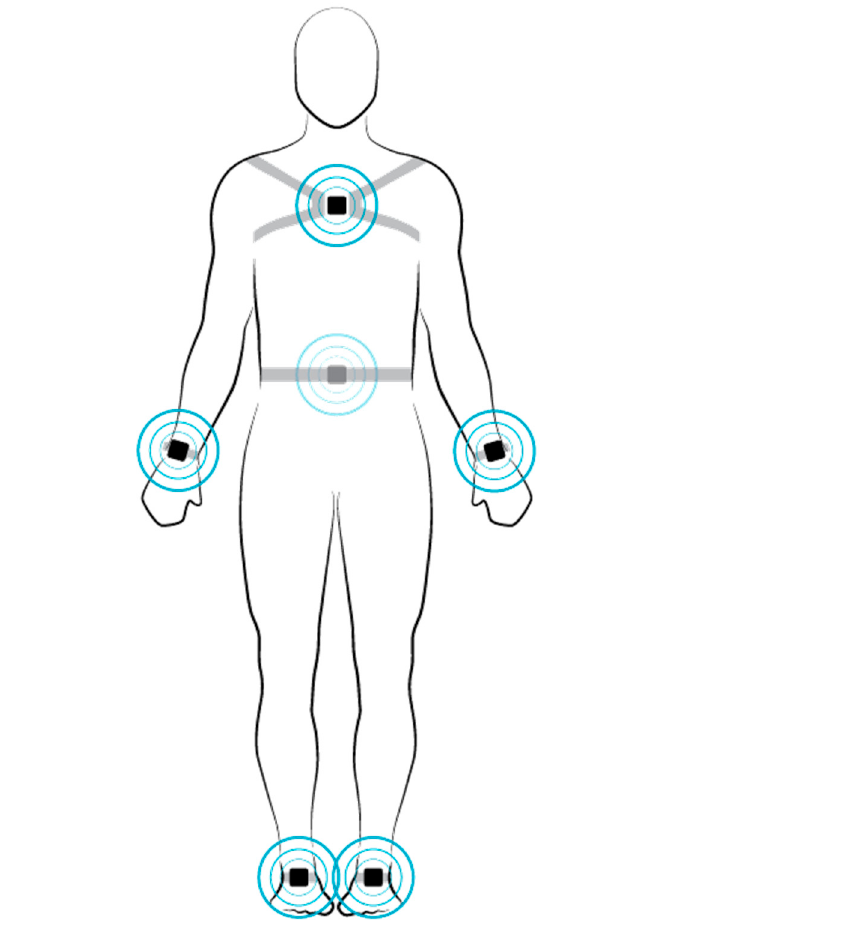
Figure 1. Demonstration of the six Mobility Lab sensors (APDM, Portland, OR, United States), both sensors applied to the forefoot serve as the basis for the calculation.